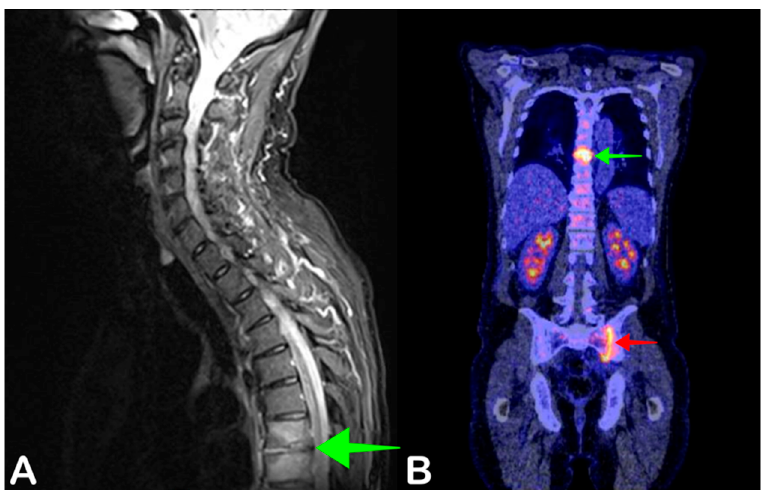
Figure 5. A 63-year-old man presented with fever and back pain. His left upper leg was also painful. Blood cultures were positive for Staphylococcus aureus. Sagittal fat-suppressed T2-weighted MRI showed increased signal intensity of thoracic vertebrae seven and eight, and the seventh and eighth intervertebral discs of the thoracic vertebrae–disc complex confirming the spondylodiscitis found on MRI ( B , green arrow), but also showed increased FDG uptake at the left sacroiliac joint, indicative of sacroiliitis ( B , red arrow). Antibiotic therapy was continued for six weeks after which the patient recovered.